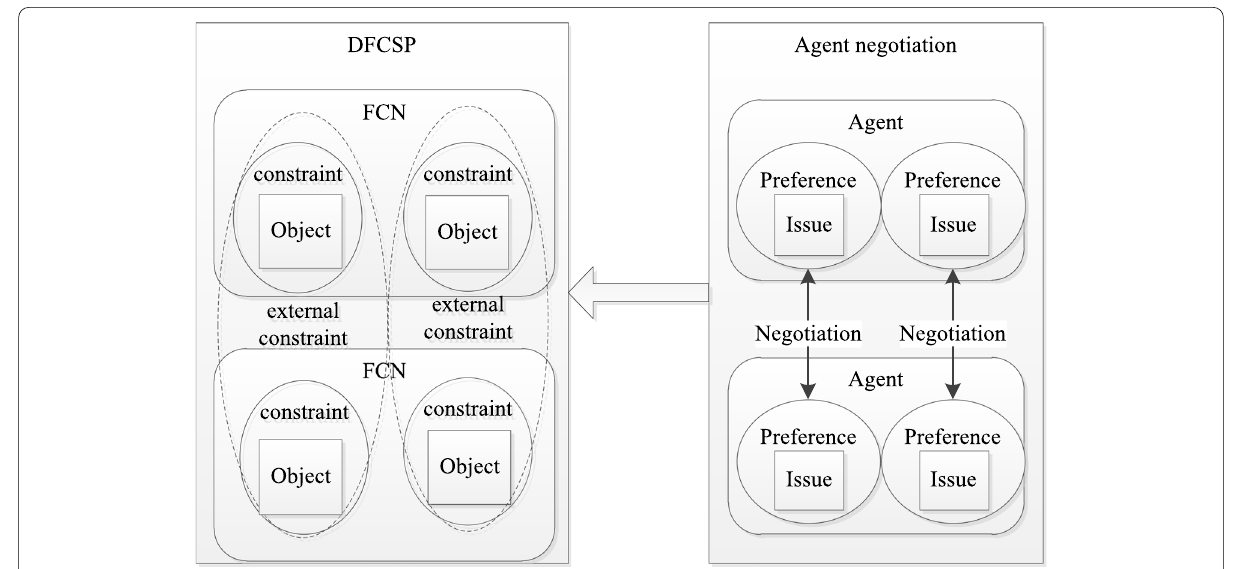
Fig. 4 Agent negotiation formulated by the